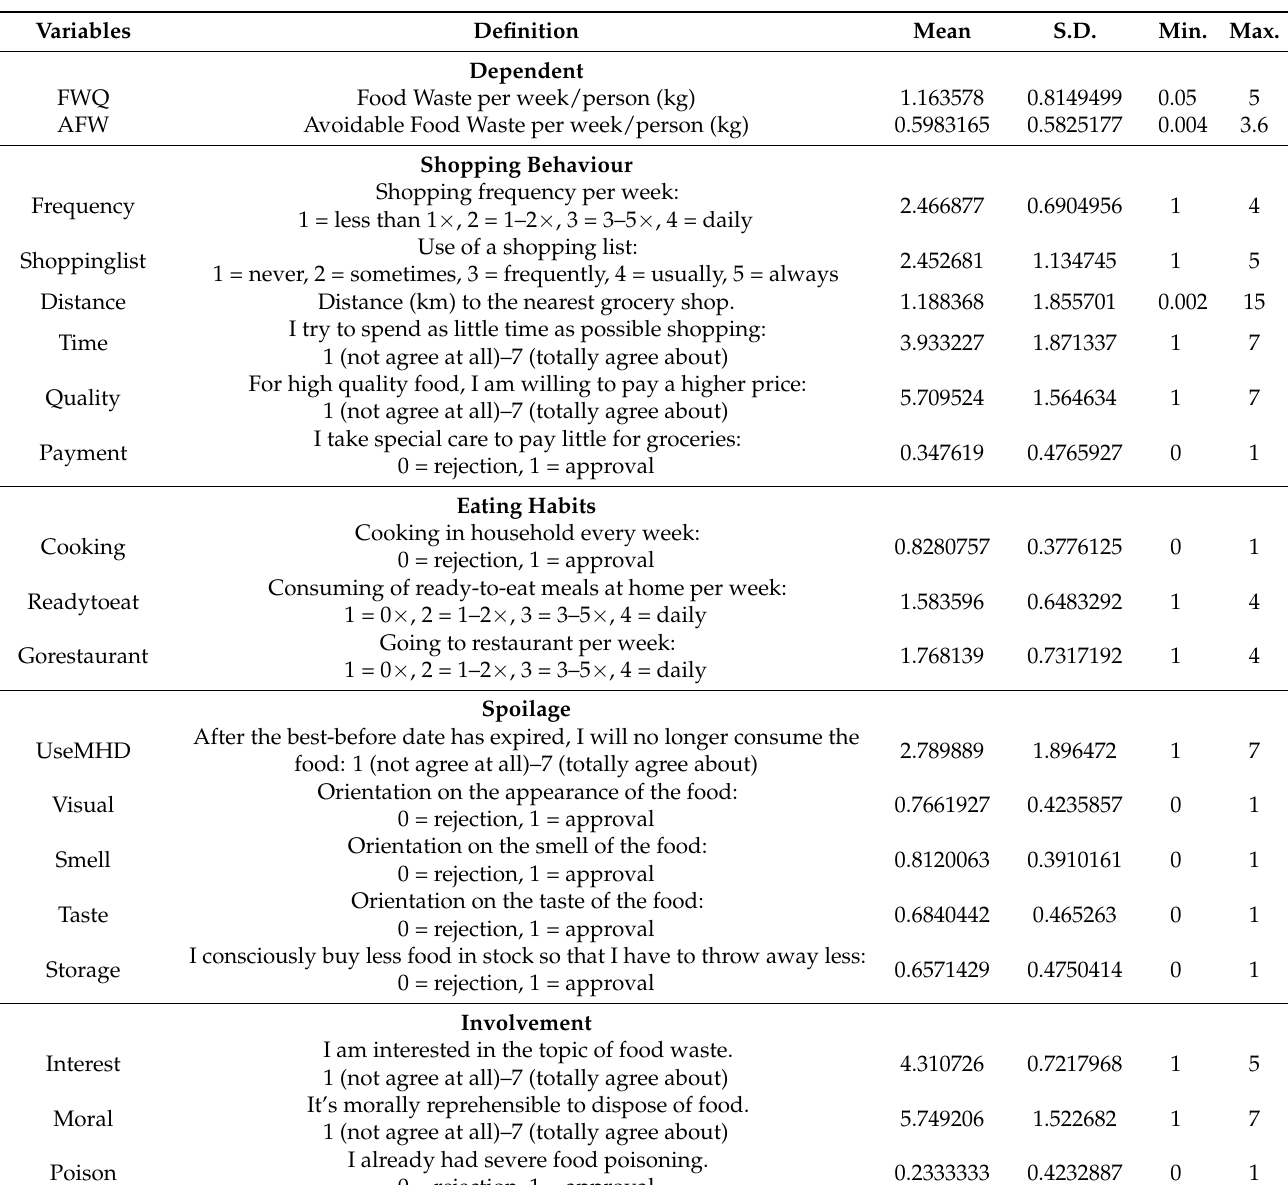
Table 5. Descriptive statistics of the main